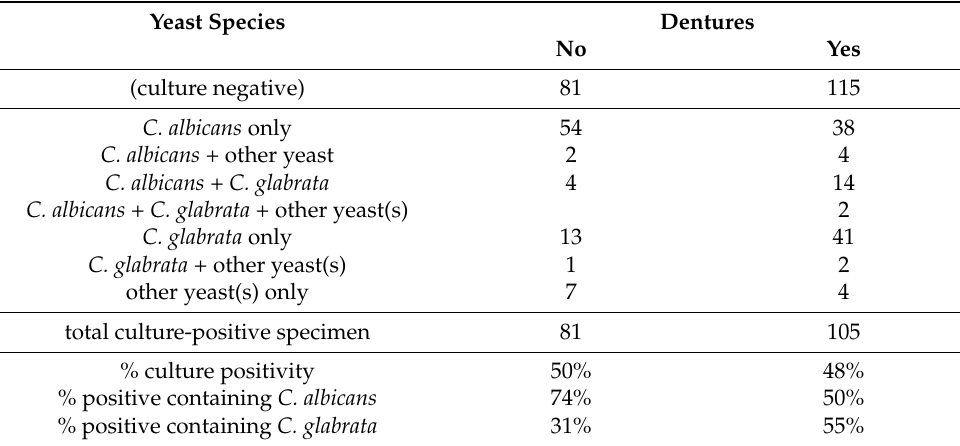
Table 2. Culture composition from the oral